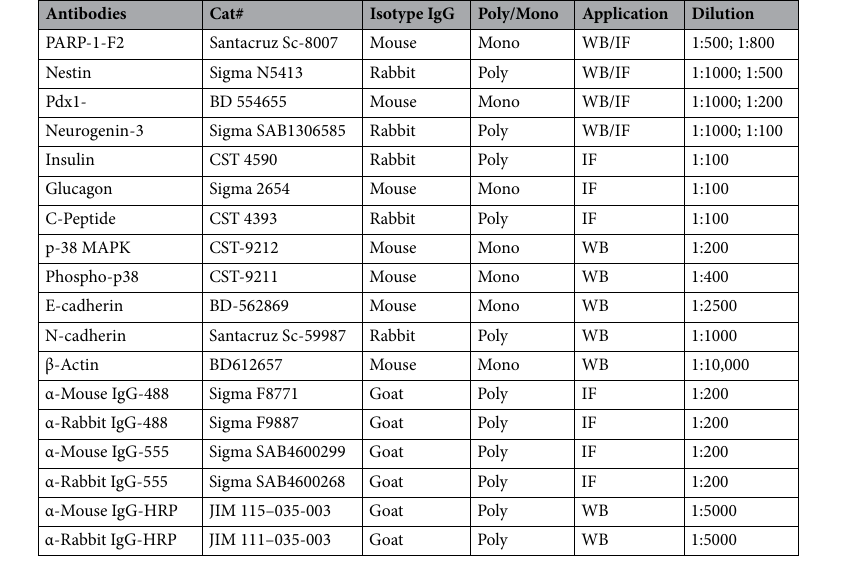
Table 2. List of antibodies used in the study.